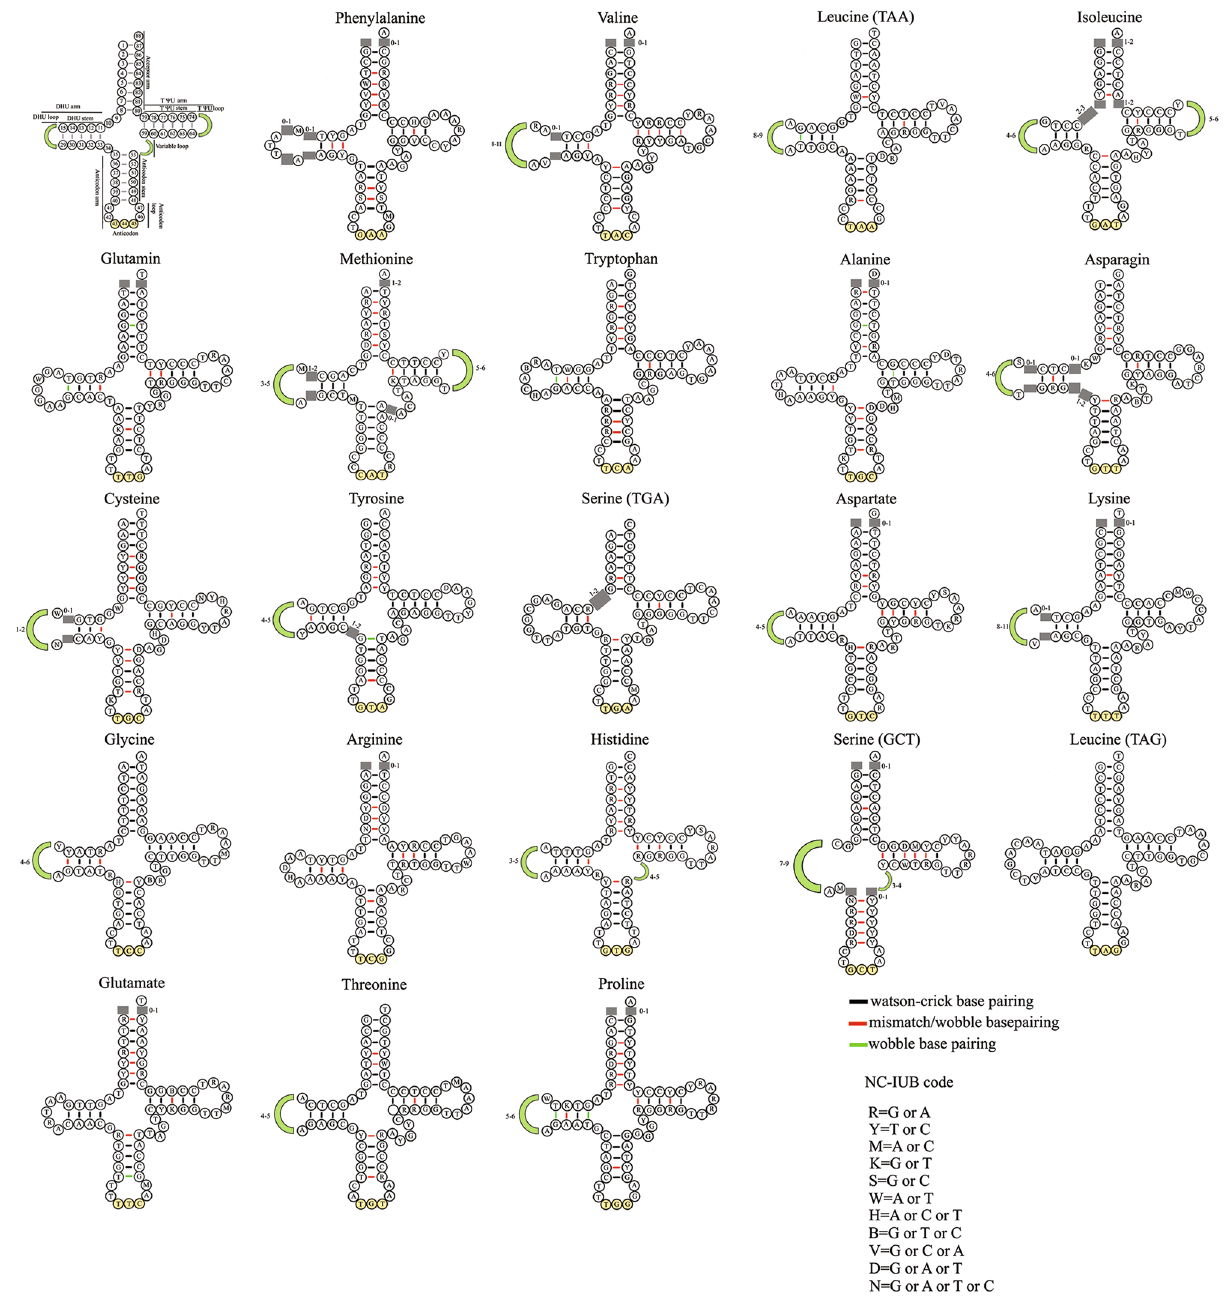
Figure 1. Secondary structure of tRNAs showing structural variations in 37 species. The first structure represents the nucleotide positions common to all tRNAs (1–88) and details of stem- loop. Length variations in stems and loops are indicated by grey squares and green arcs respectively. The secondary structure of tRNAs were predicted by ARWEN software (http:// 130. 235. 244. 92/ ARWEN/) and edited manually in Adobe Photoshop